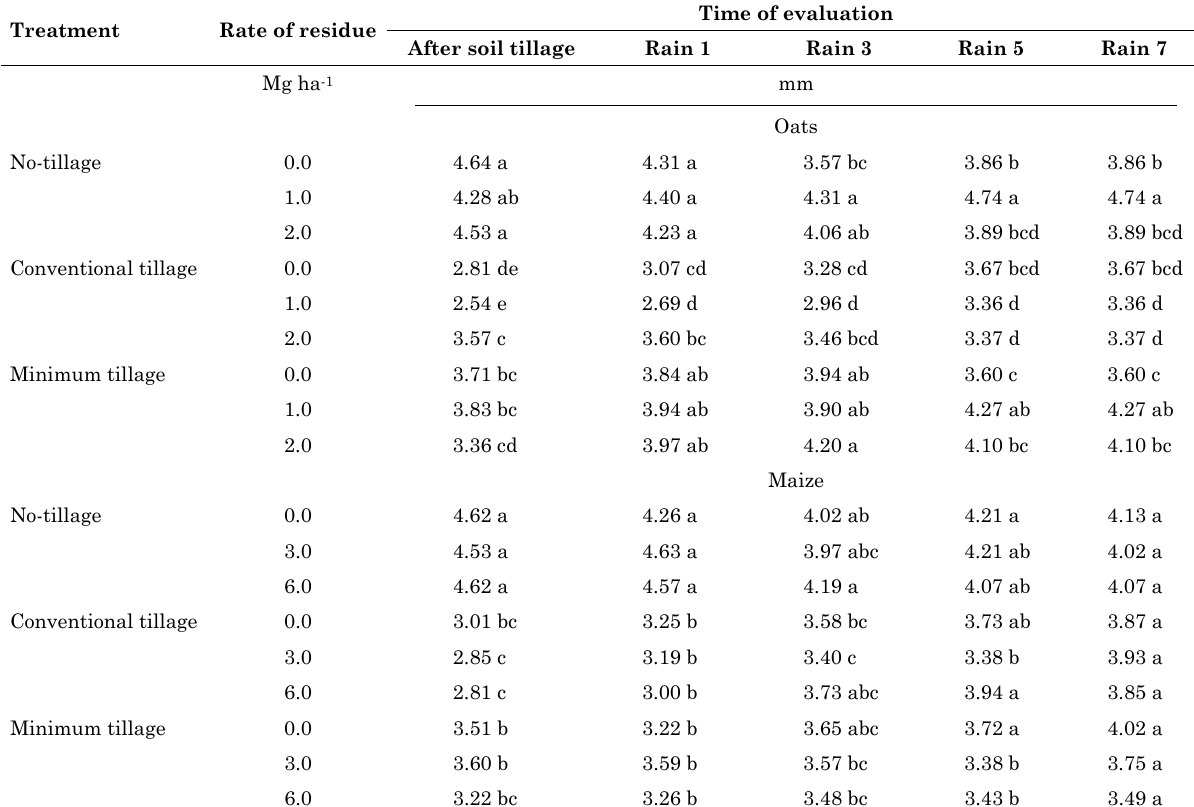
Table 3. Values of mean geometric diameter of the aggregates in the treatments under diverse rates of oat and maize residue in the 0-0.05 m soil layer Treatment Rate of residue